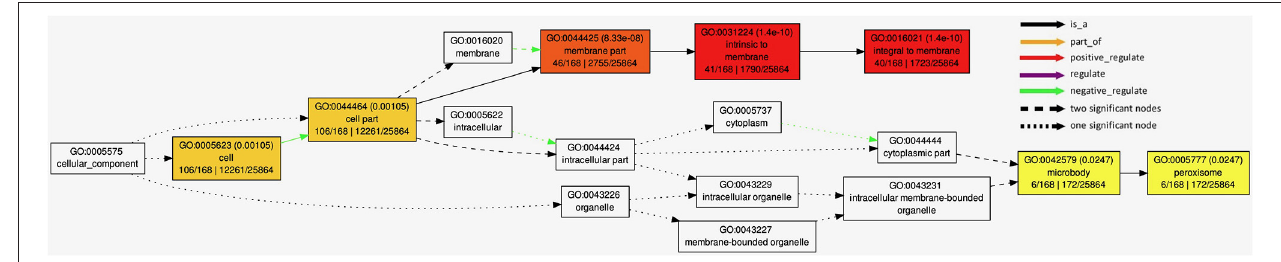
FIGURE 6 | Results of AgriGo gene ontology (GO) enrichment analysis with genes detected by BioMart tool ( Supplementary Table S3 ) for cellular